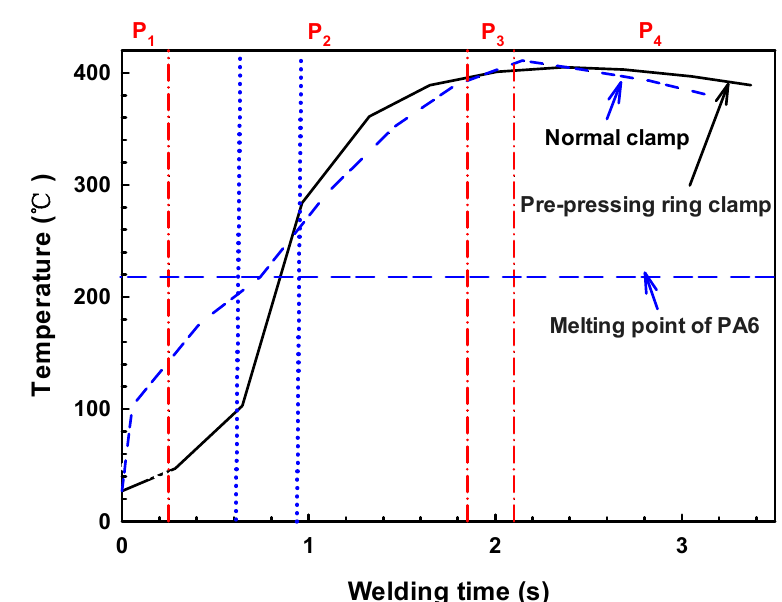
Figure 7. Effect of the pre-pressing ring and normal clamps on the displacement curve of horn ( a ) and weld temperature at the faying interface ( b ).